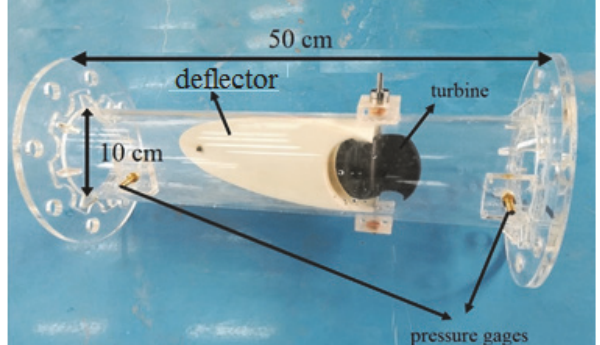
Figure 4: Two-bladed turbine test section with deflector.